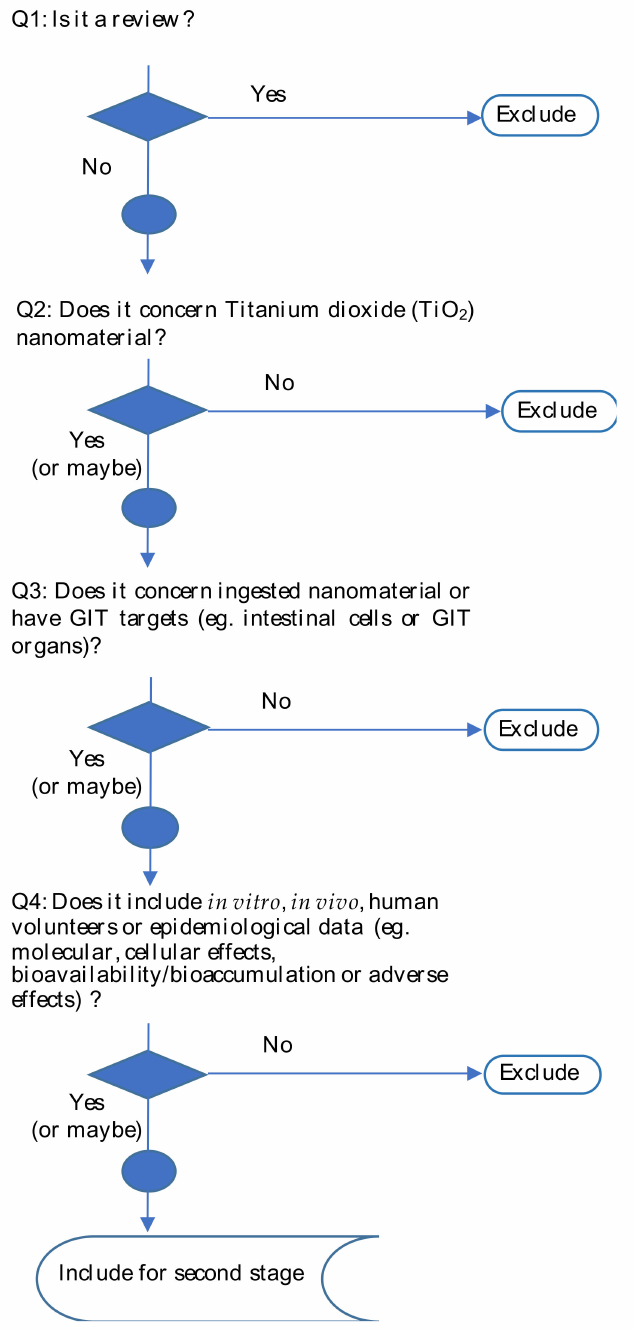
Figure 1. Decision tree for stage I